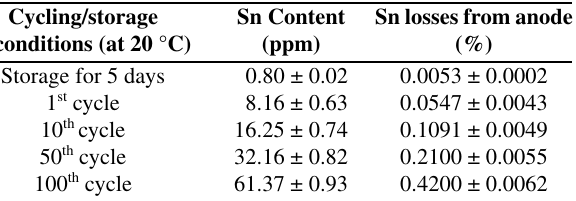
Table 2 . Zn and Fe contents (ppm) by metal dissolution in the electrolyte (EC:DEC (3:7), 1M LiPF des, detected by the TXRF method. Fe and Zn losses (%) are related to the sample weight. electrolyte solution: 100 μL; active mateial of ZnFe 1.55 mg cm –2 , the error for the active material (ZnFe